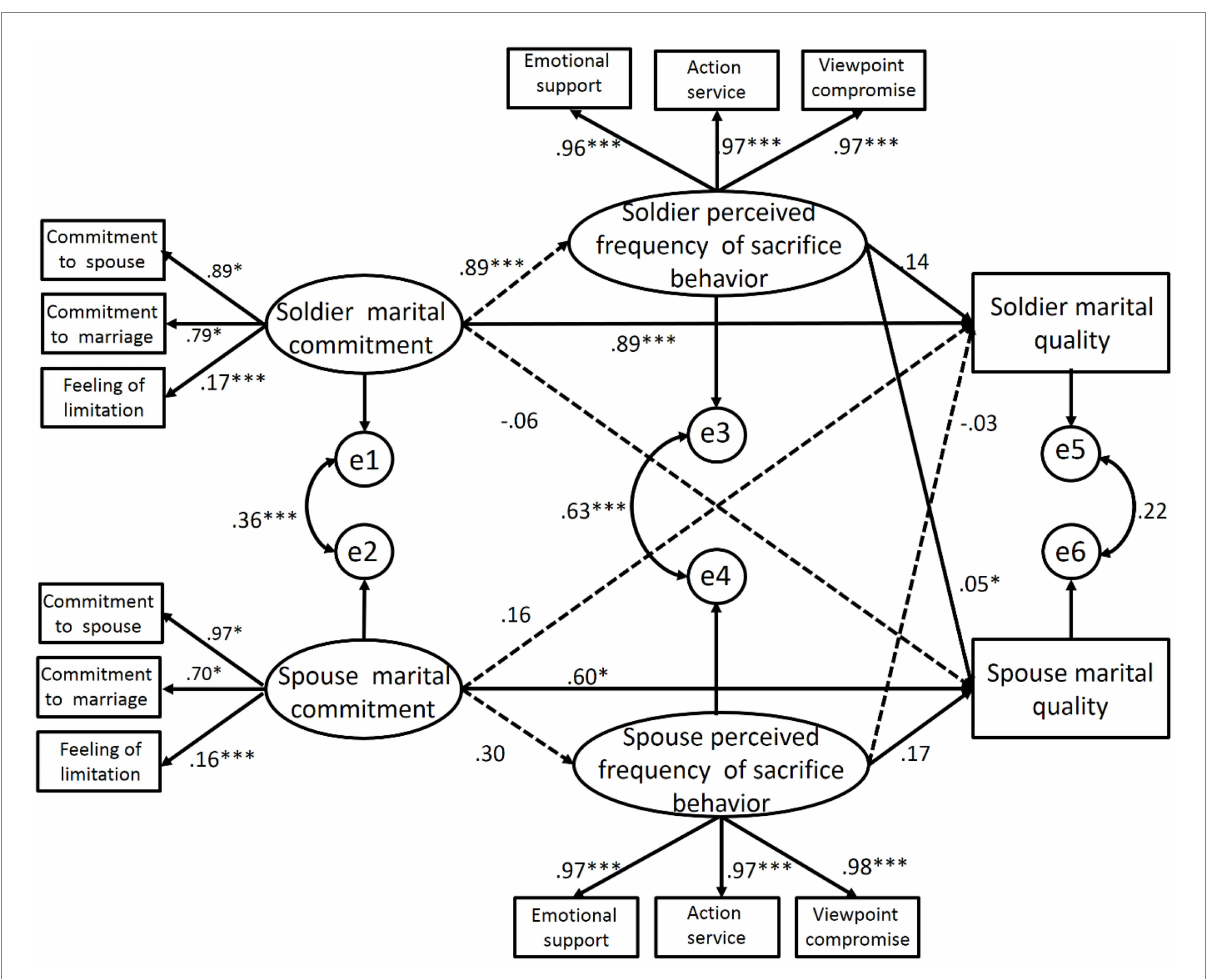
FIGURE 3 The path of marital commitment, perceived sacrifice behavior frequency and marital quality of military couples. * p < 0.05; *** p <